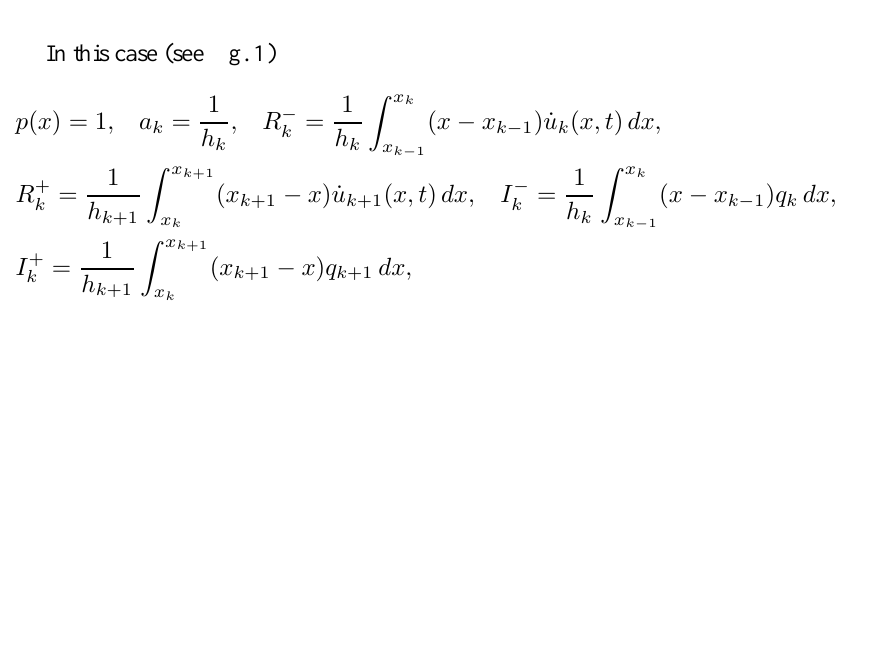
Figure 1. The calculated temperature u 1 in the layer x = x 1 in the case of Cartesian coordi-